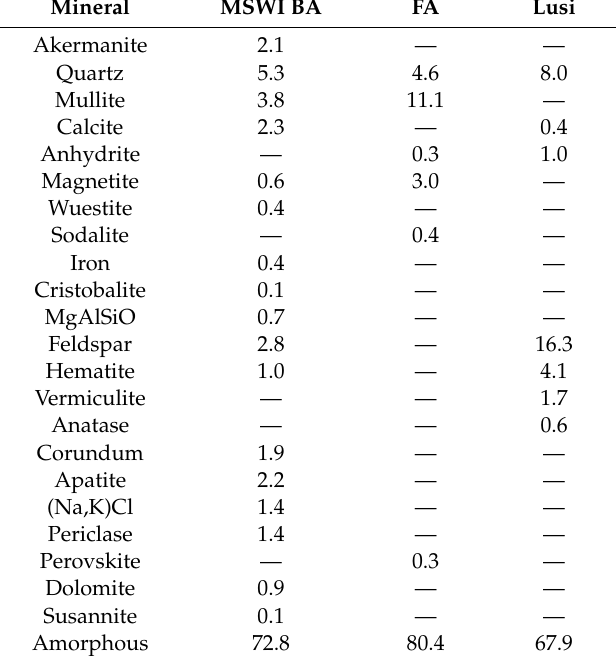
Table 4. Quantitative X-ray Di ff raction of municipal solid waste incineration bottom ash (MSWI BA), fly ash (FA), and Lusi.